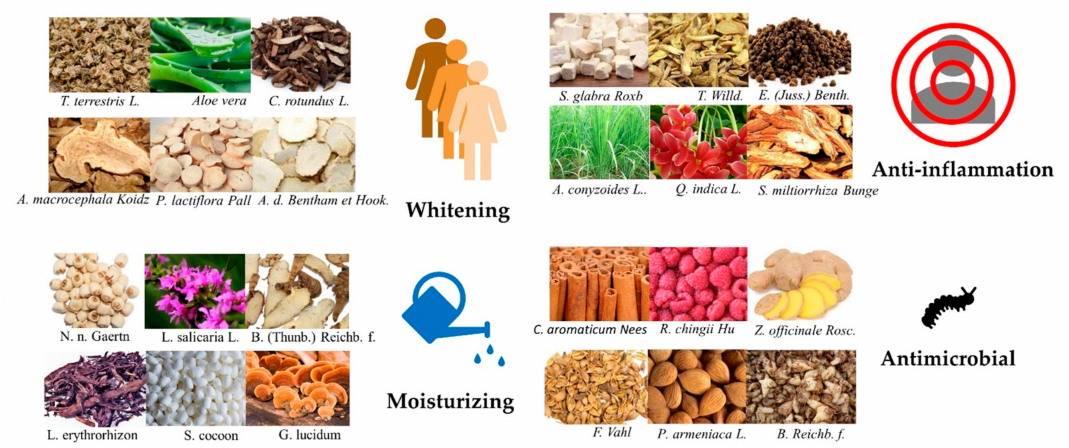
Figure 3. Natural products in various types of therapeutic